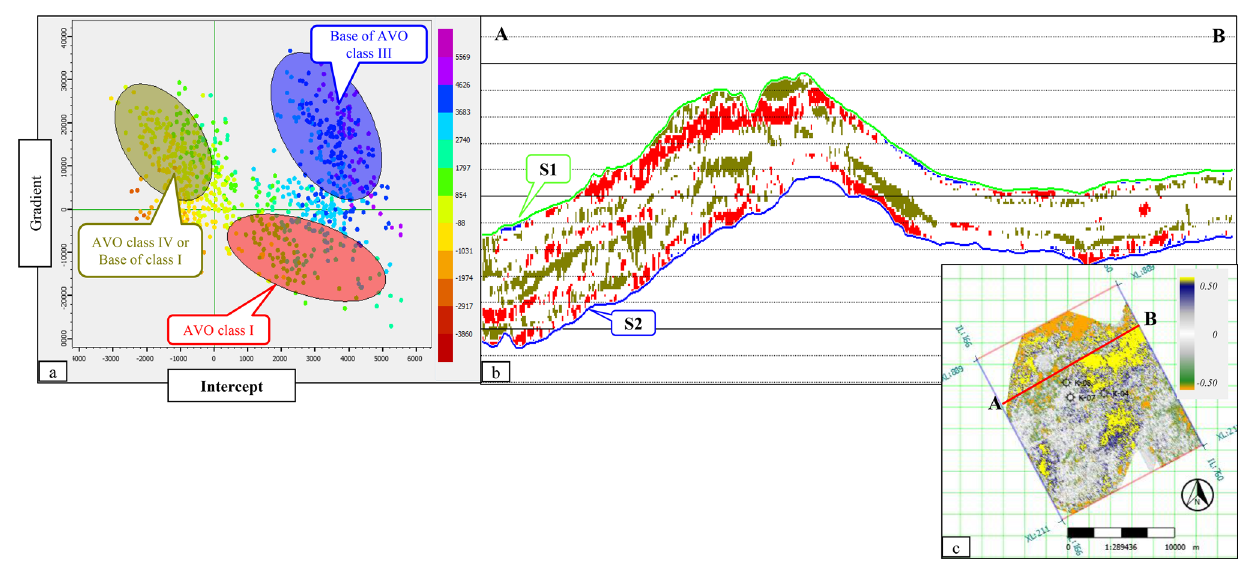
Fig. 13 AVO attributes analysis: a intercept versus gradient cross-plot from seismic data highlighting effects of changes in reservoir proper- ties on AVO response, b seismic cross section along the AVO cap-